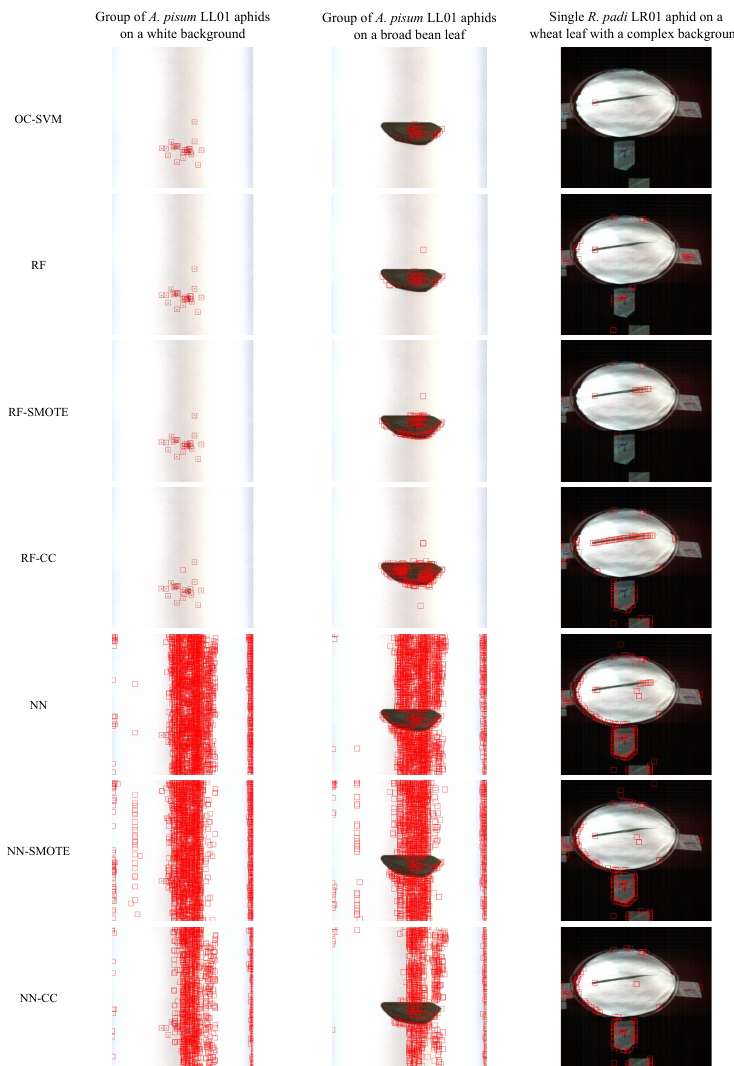
Figure 8. Aphids detected by the LoG method (red bounding boxes), on score images obtained using each scheme (represented in each row), on three challenging images. The first two images represent a group of A. pisum LL01 aphids at stage N1 on a white background ( column 1 ) or on a broad bean leaf ( column 2 ), and the third image represents a single R. padi LR01 aphid on a wheat leaf with a complex background ( column 3 ).